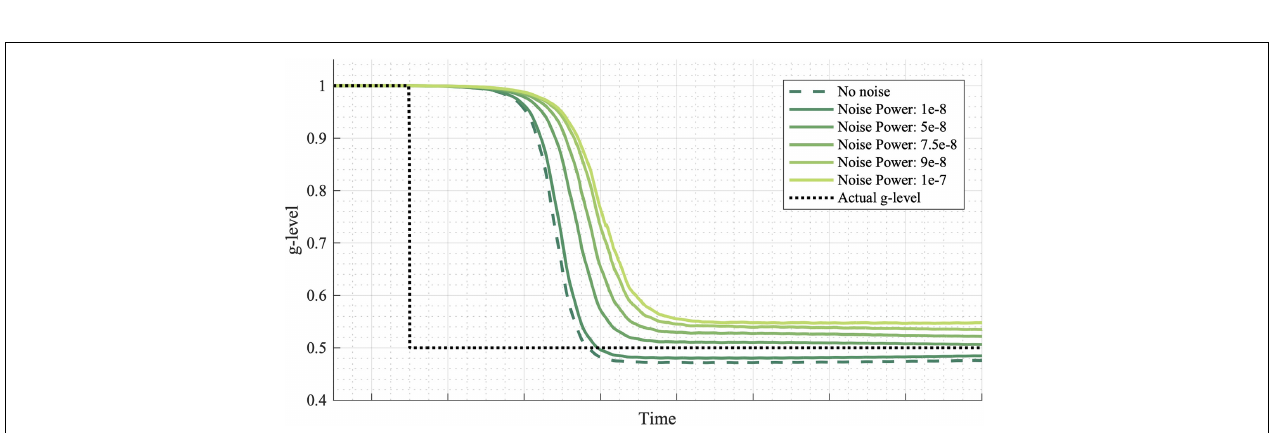
FIGURE 7 | Effects of noise power on adaptation rates. Noise is added to the incoming measurements at various power levels. Higher noise powers result in slower adaptation initialization, though not necessarily slower convergence to the exact g-level. Inputted passive motion profiles were sinusoidal, head-centered roll-tilt (amplitude, 15 ◦ ; frequency, 0.125